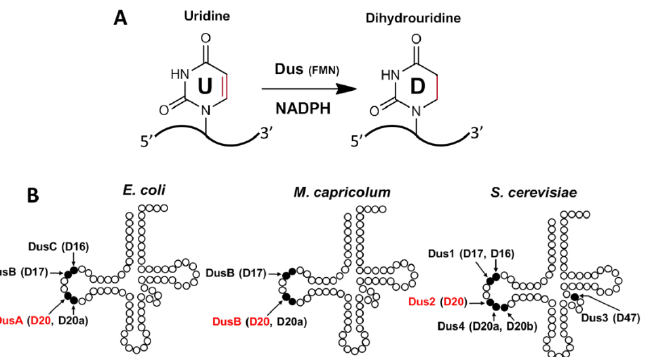
Figure 1. Dihydrouridine biosynthesis and localization of D residues in the tRNA. ( A ) Reduction reaction of uridine to dihydrouridine in tRNAs and mRNAs catalyzed by dihydrouridine synthases (Dus). These proteins are flavoenzymes that use FMN as a redox coenzyme and NADPH as a reductant source. ( B ) Cloverleaf secondary structure of the tRNAs shows the location of the D residues as well as the Dus enzymes that introduce them into Escherichia coli , Mycoplasma capricolum , and Saccharomyces cerevisiae .